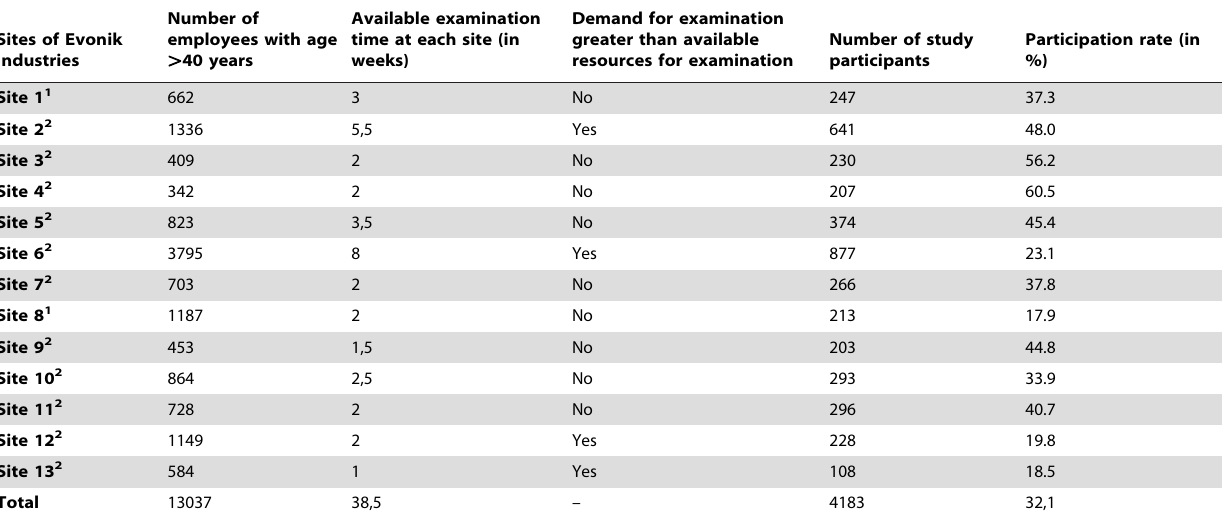
Table 2. Participation rate for each site and in total.